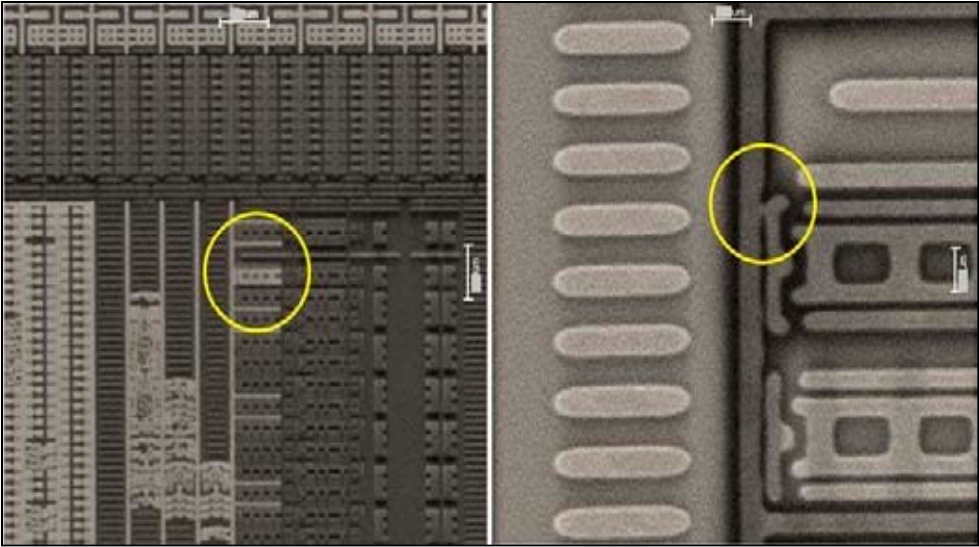
Figure 11. Dose modulated wafer inspection using e-beam to correlate physical defects with voltage contrast signal variations. contrast signal